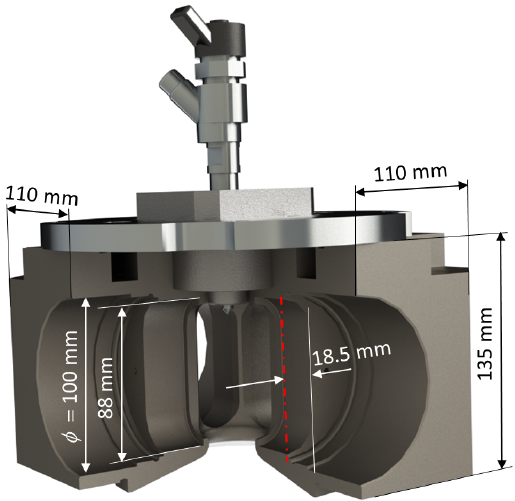
Figure 3. Modified engine head with selected